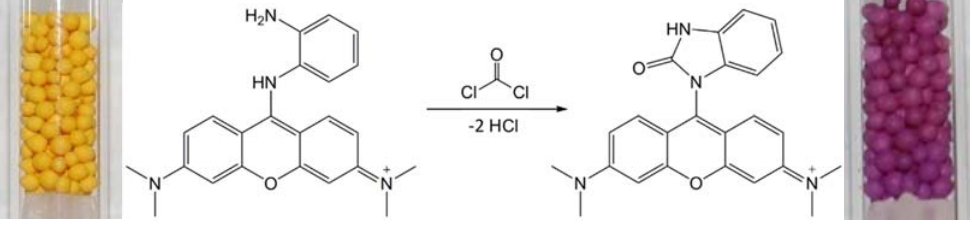
Figure 3. Phosgene reaction with PY ‐ OPD and detection tube indication charge.